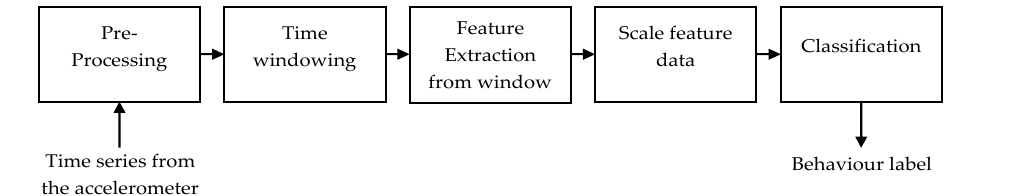
Figure 2. Overview of consecutive steps of the behavior classification process (adopted and modified from Figure 2 in ref [20]).